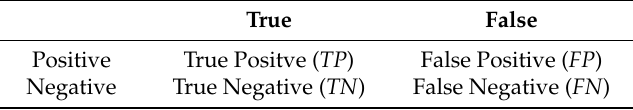
Table 2. Discriminant criteria for dichotomous